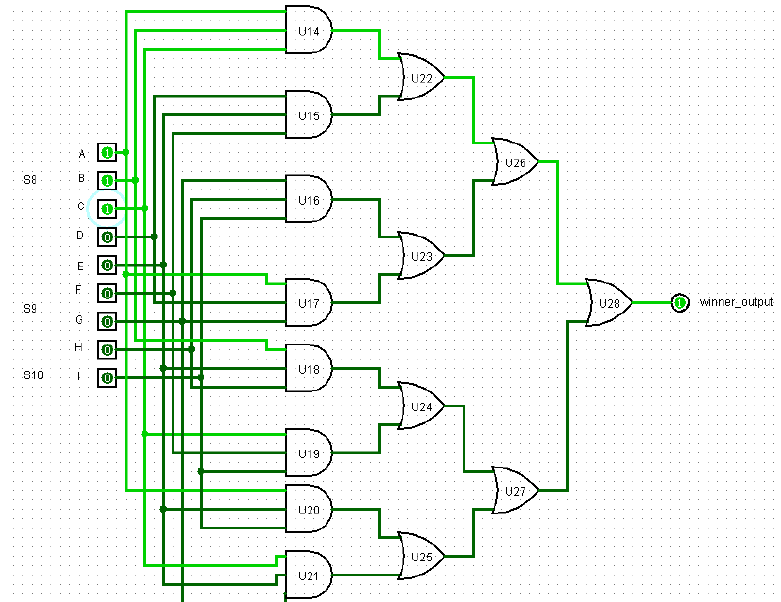
Figure A3. Winner circuit (Logisim).